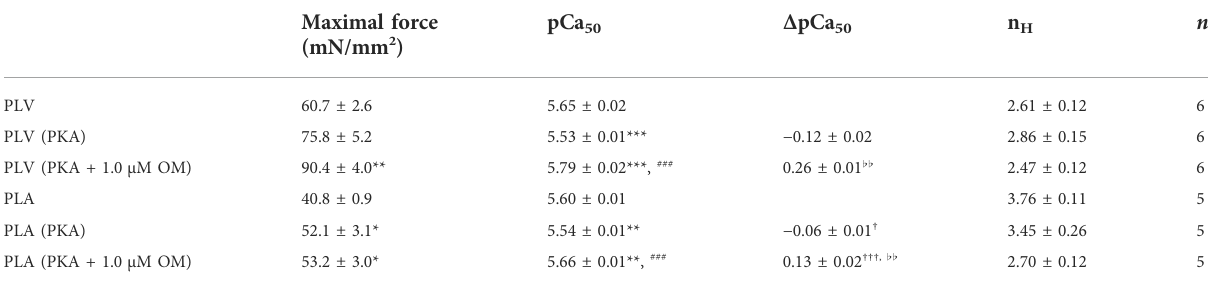
TABLE 2 Summary of the effects of OM on maximal force, Ca 2+ sensitivity and n H in PLV and PLA following PKA